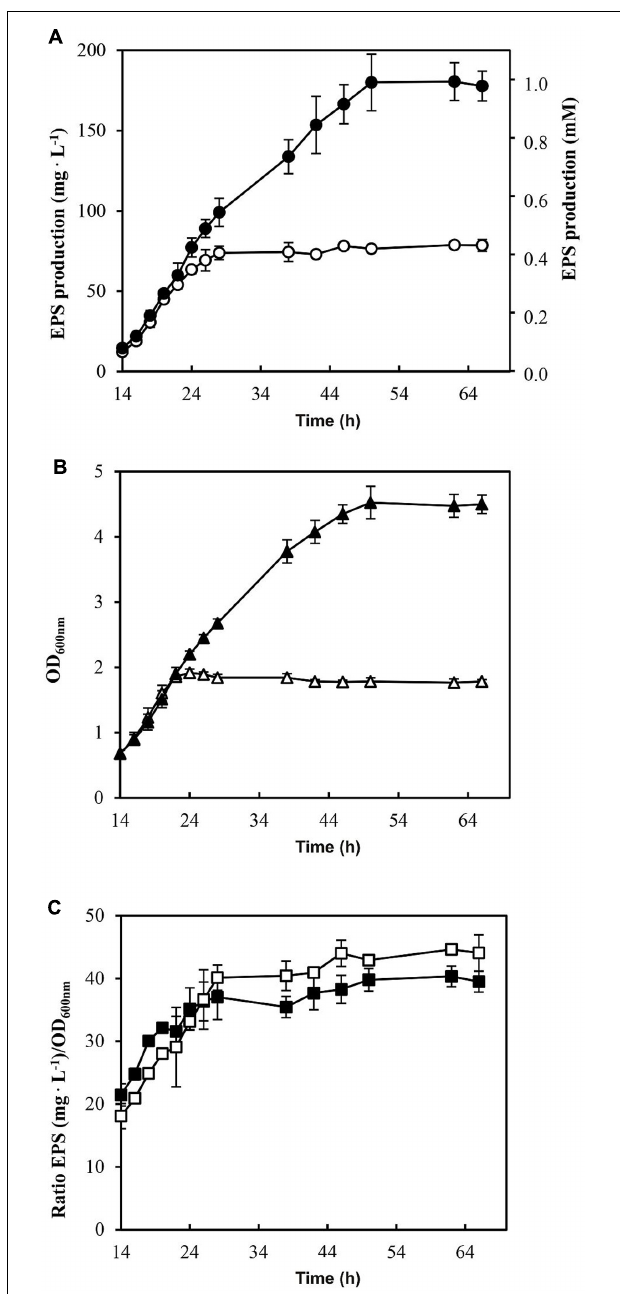
FIGURE 3 | Analysis of EPS production by P. parvulus 2.6 in MRSGS